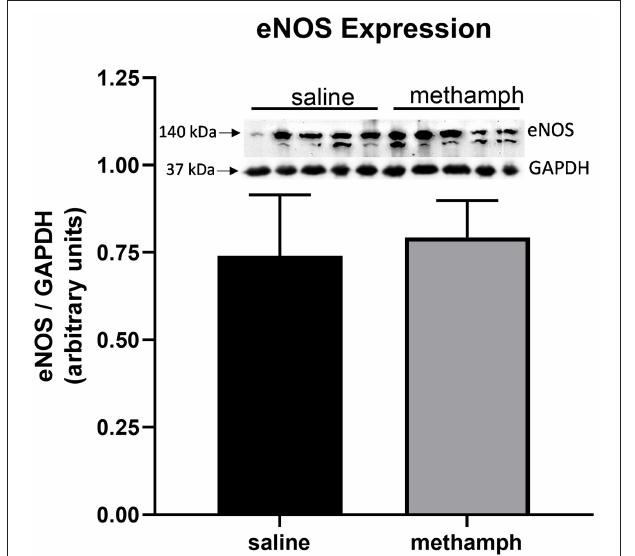
FIGURE 5 | Prenatal methamphetamine exposure had no effect on eNOS expression in male PVAT. Female rats received daily subcutaneous injections of methamphetamine (5 mg/kg) or saline starting on gestational day 1 and continuing until the pups were born. PVAT was isolated from the aortas of male offsping and analyzed by western blotting for endothelial nitric oxide synthase (eNOS) and glyceraldehyde-3-phosphate dehydrogenase (GAPDH). Band intensities were quantified by NIH Image J software. eNOS expression was normalized to that of GAPDH. Bars represent the mean ± S.E.M of PVAT from 5 different male rats.